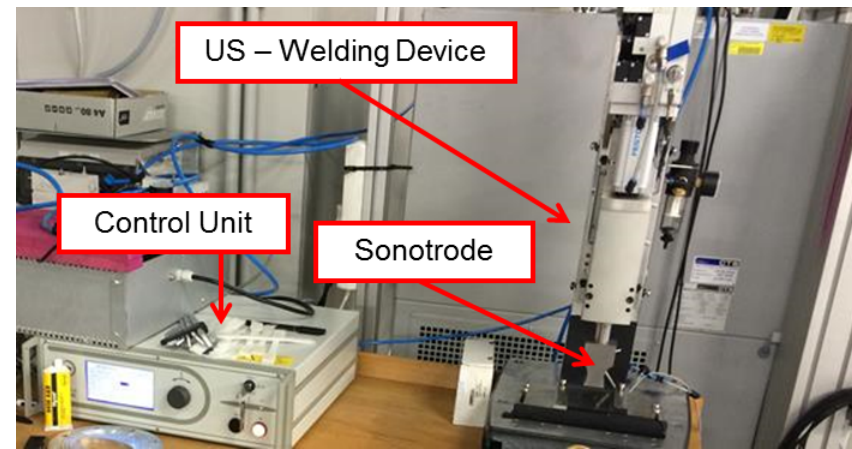
Figure 1. Ultrasonic joining device.